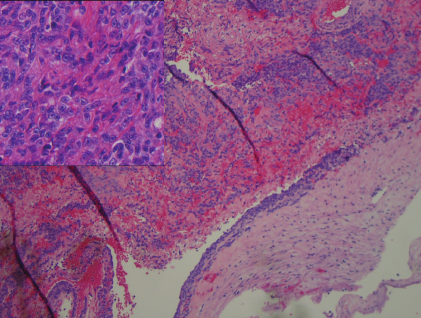
Figure 5: Medium power (100x) H&E stain of internal jugular vein wall with luminal tumor. Inset (400x) demonstrating atypical features of